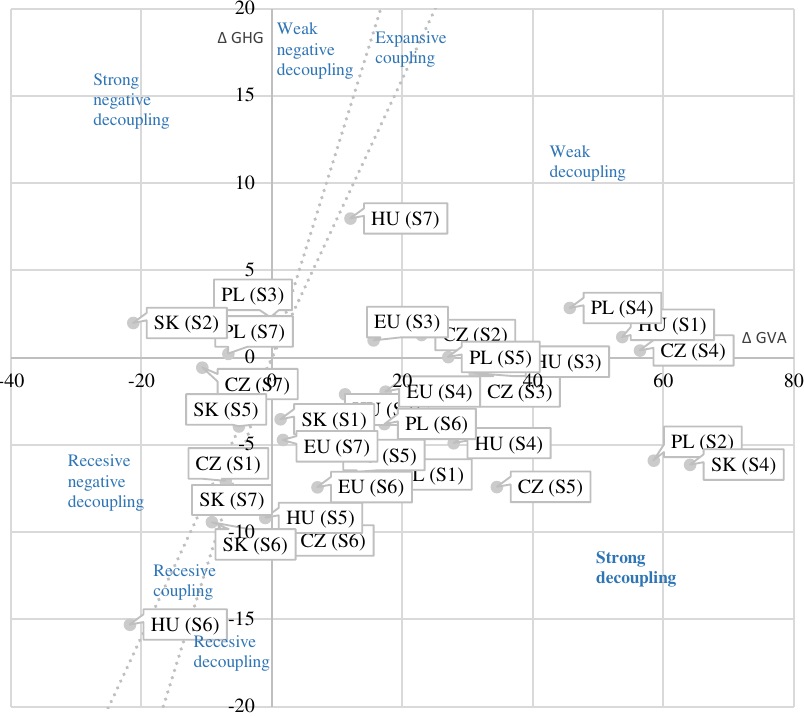
Figure 3. The distribution of V4 countries into subcategories of decoupling